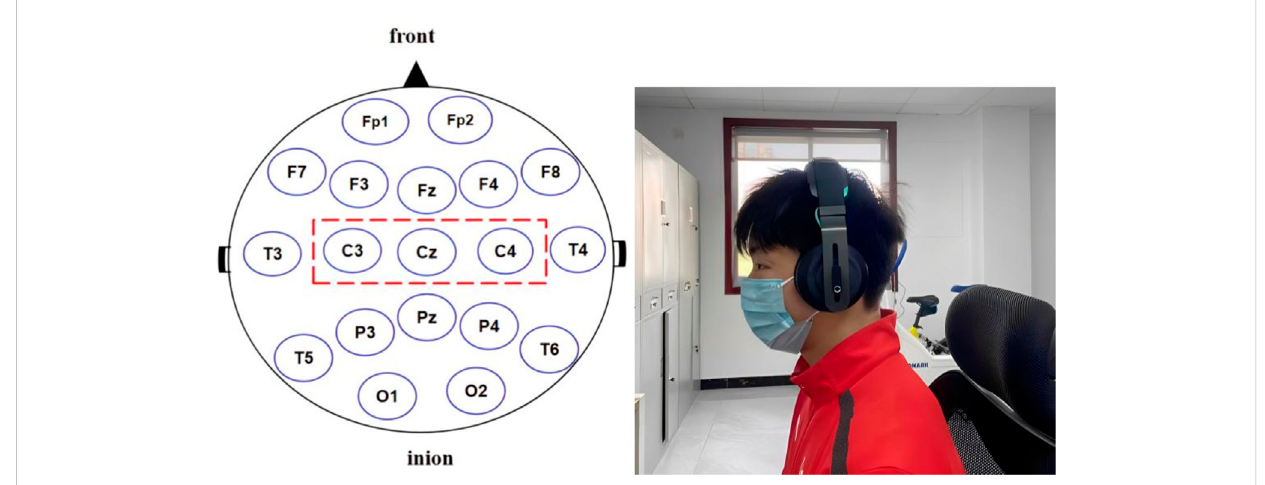
FIGURE 1 The red dotted box represents the stimulated areas in the picture on the left. The image on the right is an athlete undergoing treatment.